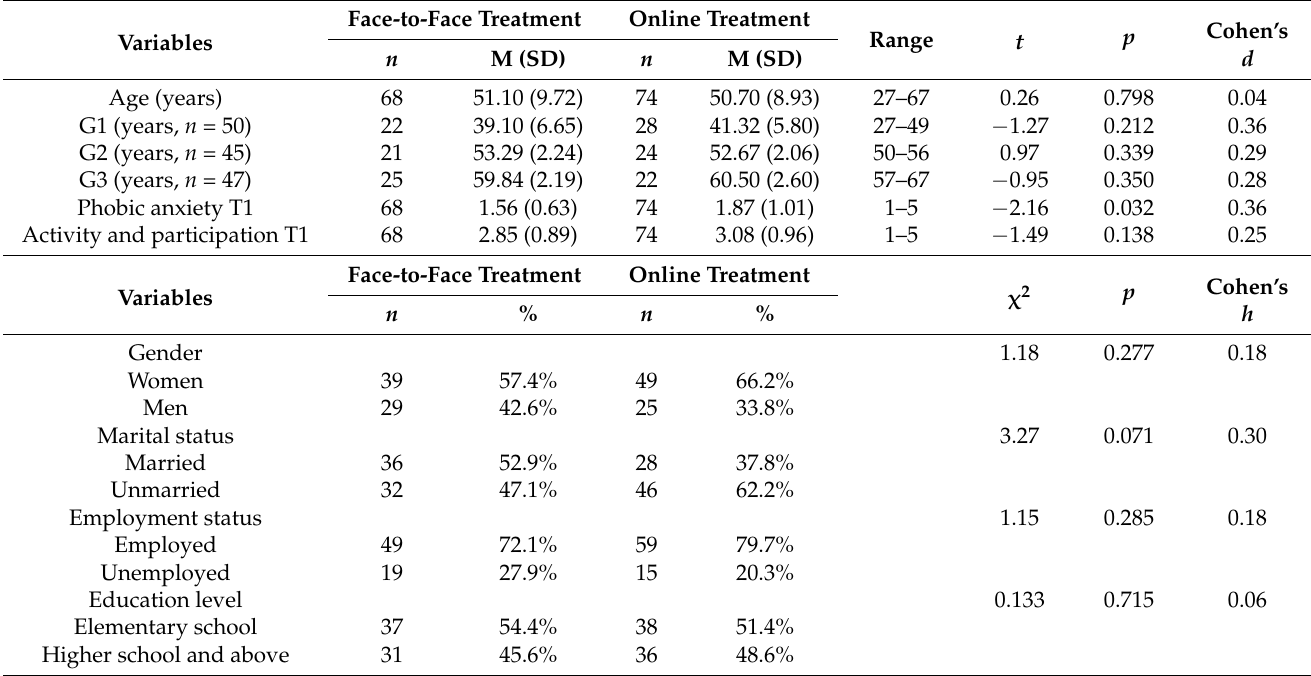
Table 1. Descriptive statistics of main study variables at baseline ( N =